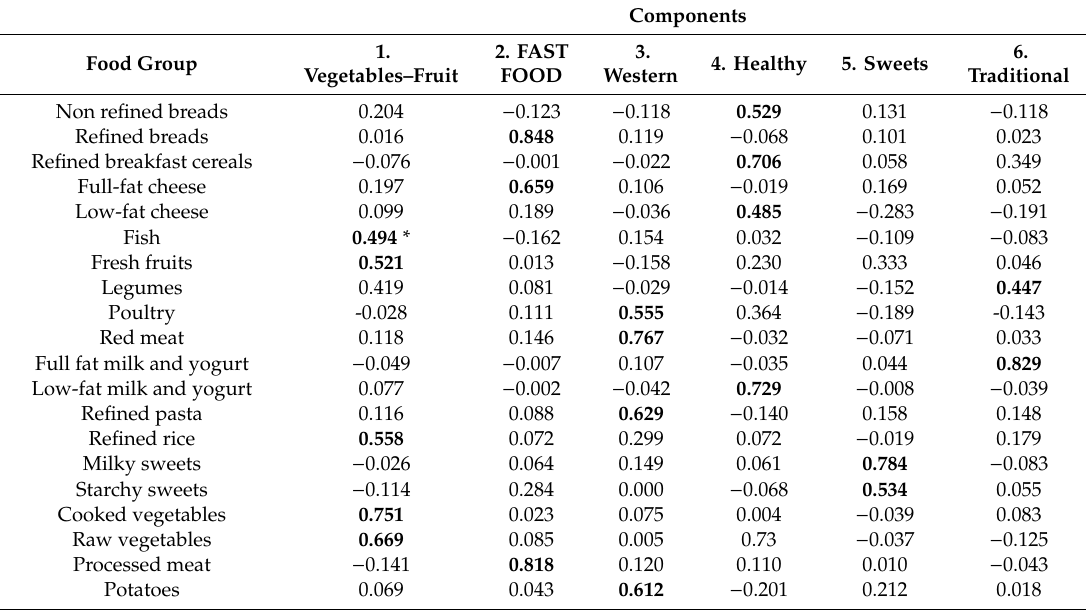
Table 2. Dietary patterns derived from principal component analysis (PCA).